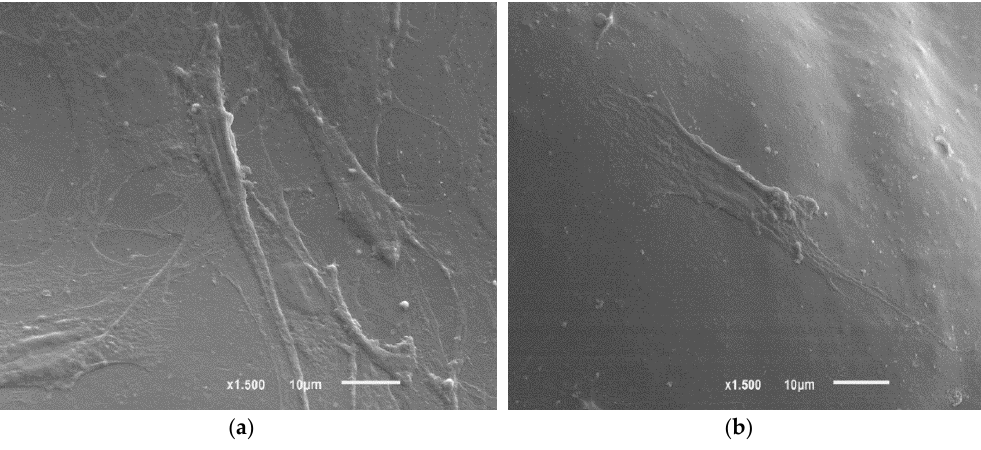
Figure 1. MTT cytotoxicity assays of MC3T3-E1 pre-osteoblast in contact with the as-prepared extraction media exposed to PLGA and PLGA composites with 30 and 50% nHA. Figure 2. Cell morphology of MC3T3-E1 pre-osteoblasts seeded on PLGA 75/25 ( a ) 10% nHA; and ( b ) 50% nHA samples after three days obtained by SEM. The scale bar is 10 μ m for all samples.